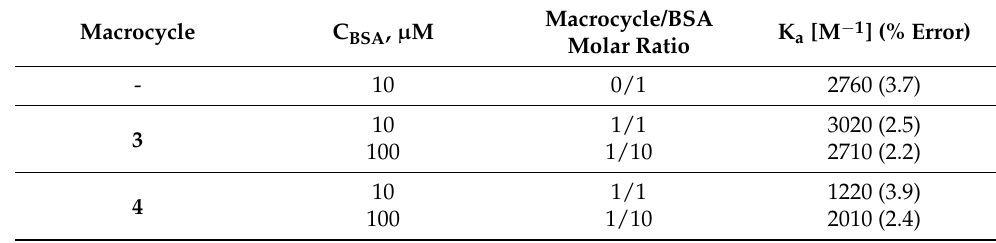
Table 4. Binding constants of ciprofloxacin with BSA in the absence and presence of 3 and 4 .